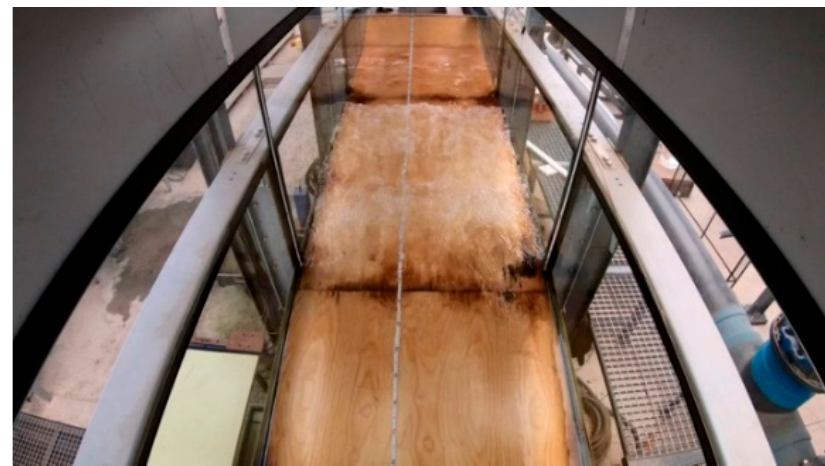
Figure 3. Run-up visualisation be means on frontal camera.